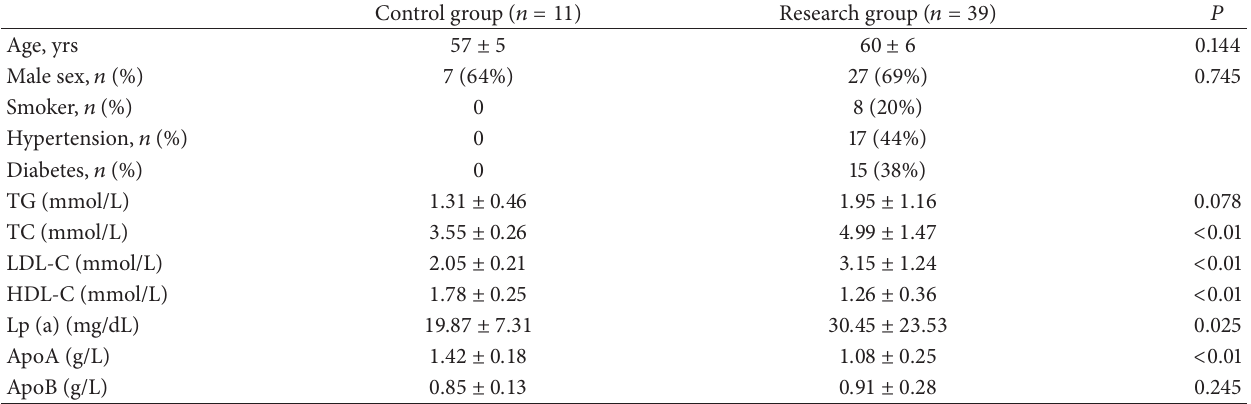
Table 1: Baseline characteristics and serum lipid levels of subjects and patients in the two